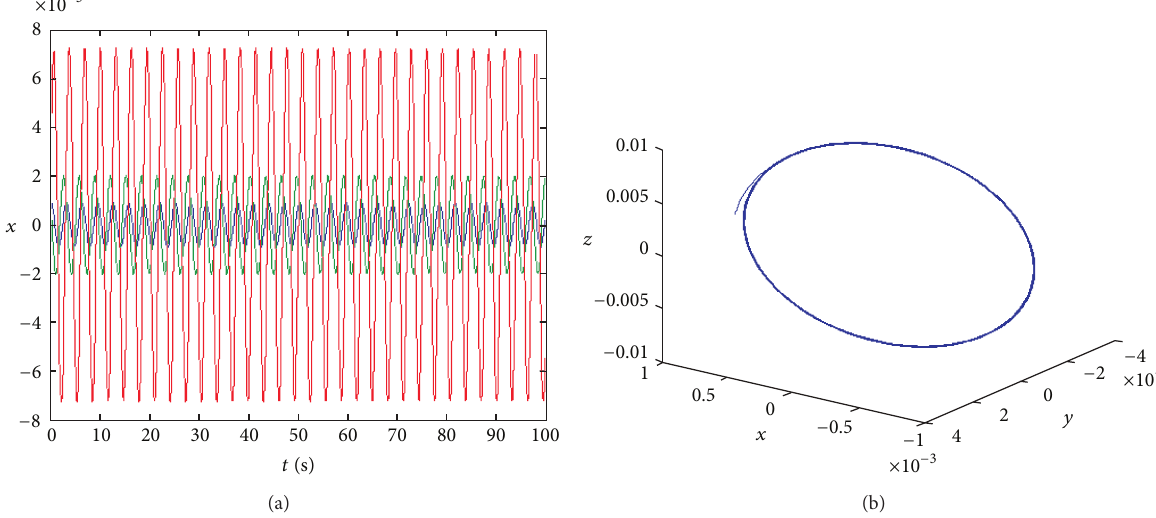
Figure 4: Time history and phase diagram of system (3) with 𝑎 = −1 , 𝑏 = 1 , 𝑐 = −1 , 𝑒 = 18 , and 𝑑 = −0.555556 .